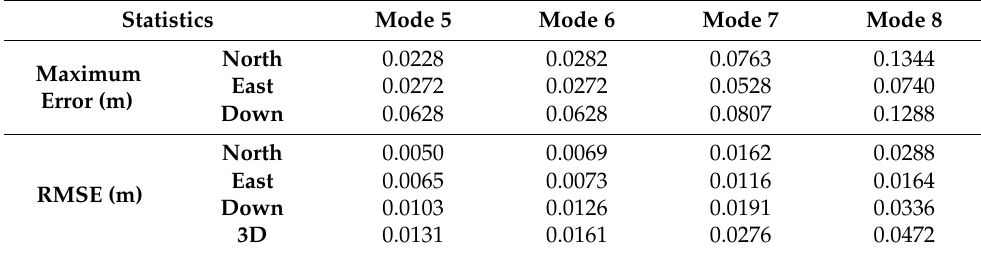
Table 7. Statistical results of relative position errors in test